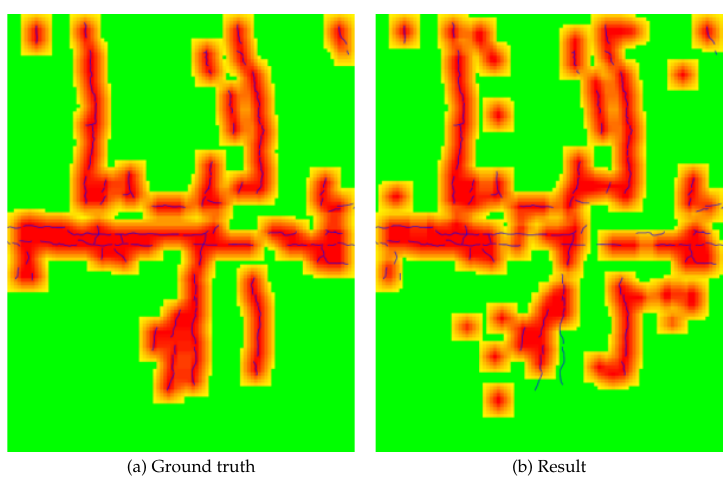
Figure 7. Examples of region-based results. The examples correspond to Figure 5C. Cracks in the image represent the ground truth. The closer the color in a patch is to red, the more positive patches are included.